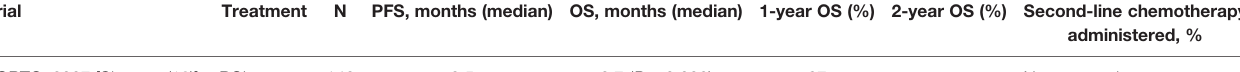
TABLE 1 | Summary of EORTC and JCOG Trials. Trial